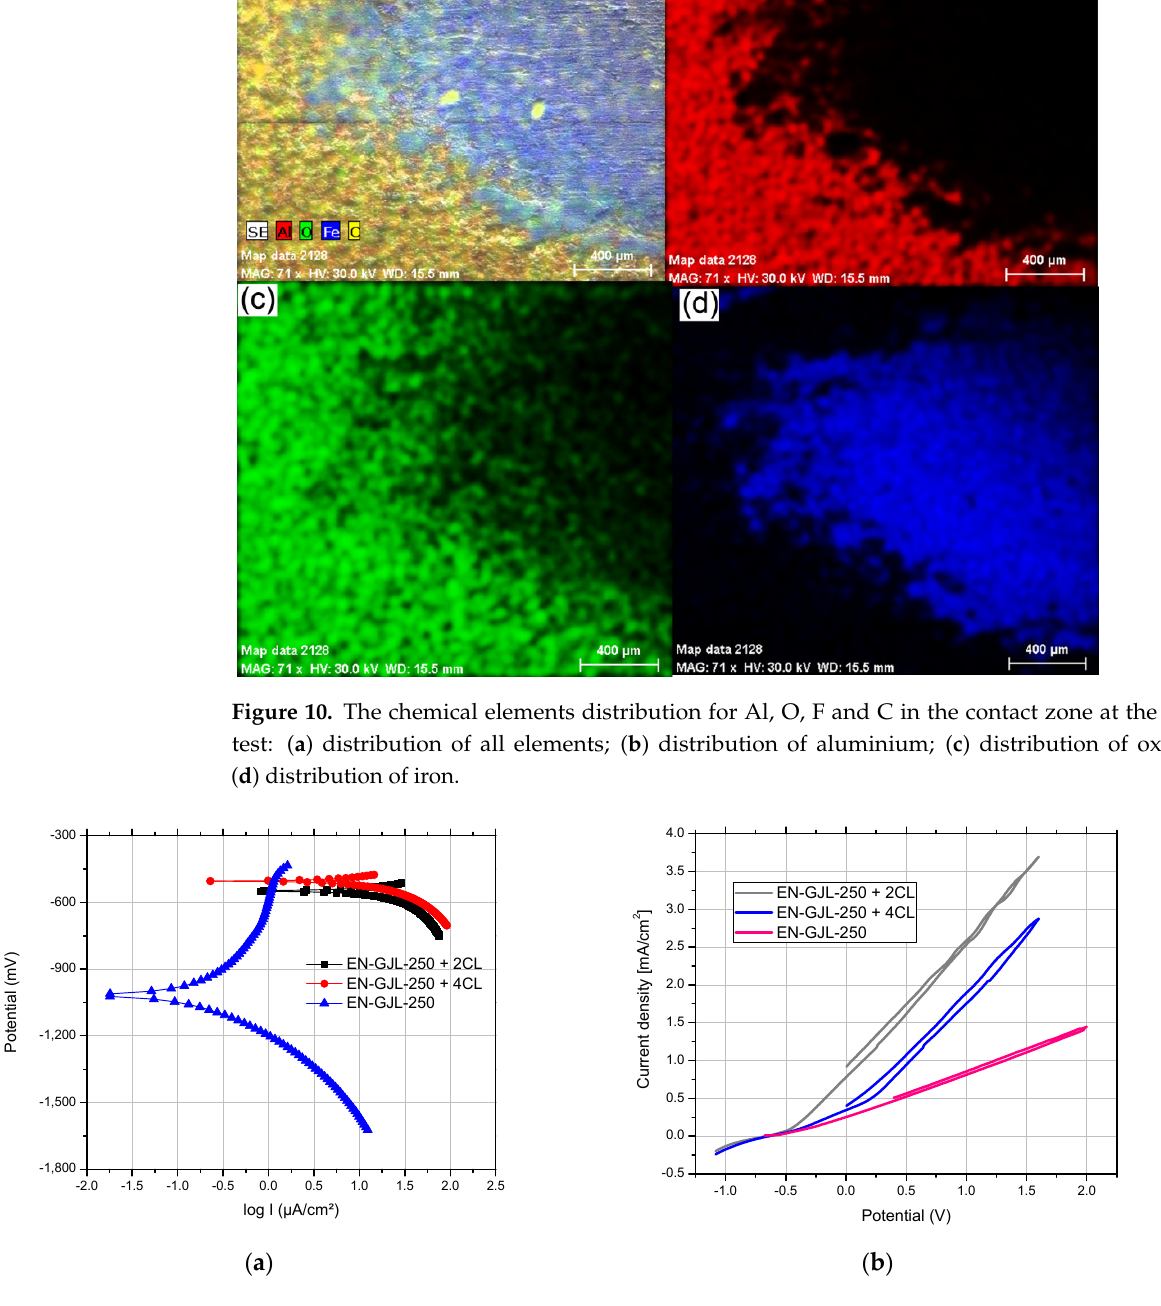
Figure 11. Potentiodynamic graphs for coated samples with Al 2 O 3 of different thicknesses on EN-GJL-250 cast iron substrate compared with the free substrate EN-GJL-250 cast iron: ( a ) linear polarisation curves; ( b ) cyclic polarisation curves.